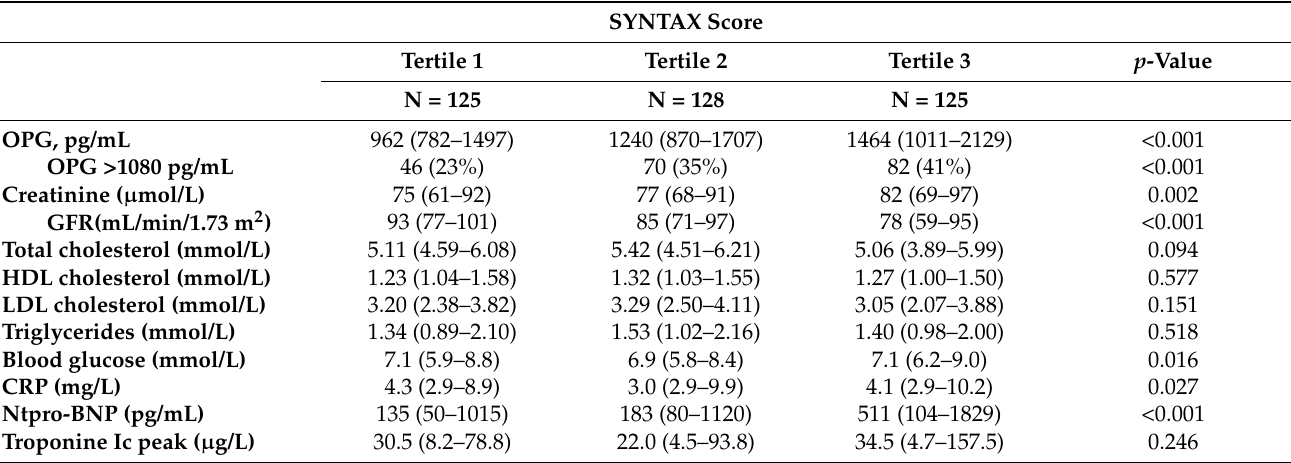
Figure 2. Median OPG levels according to SYNTAX score ( p < 0.001). Circle: outlier; *: extreme oulier. Table 2. Biological data. N(%) or